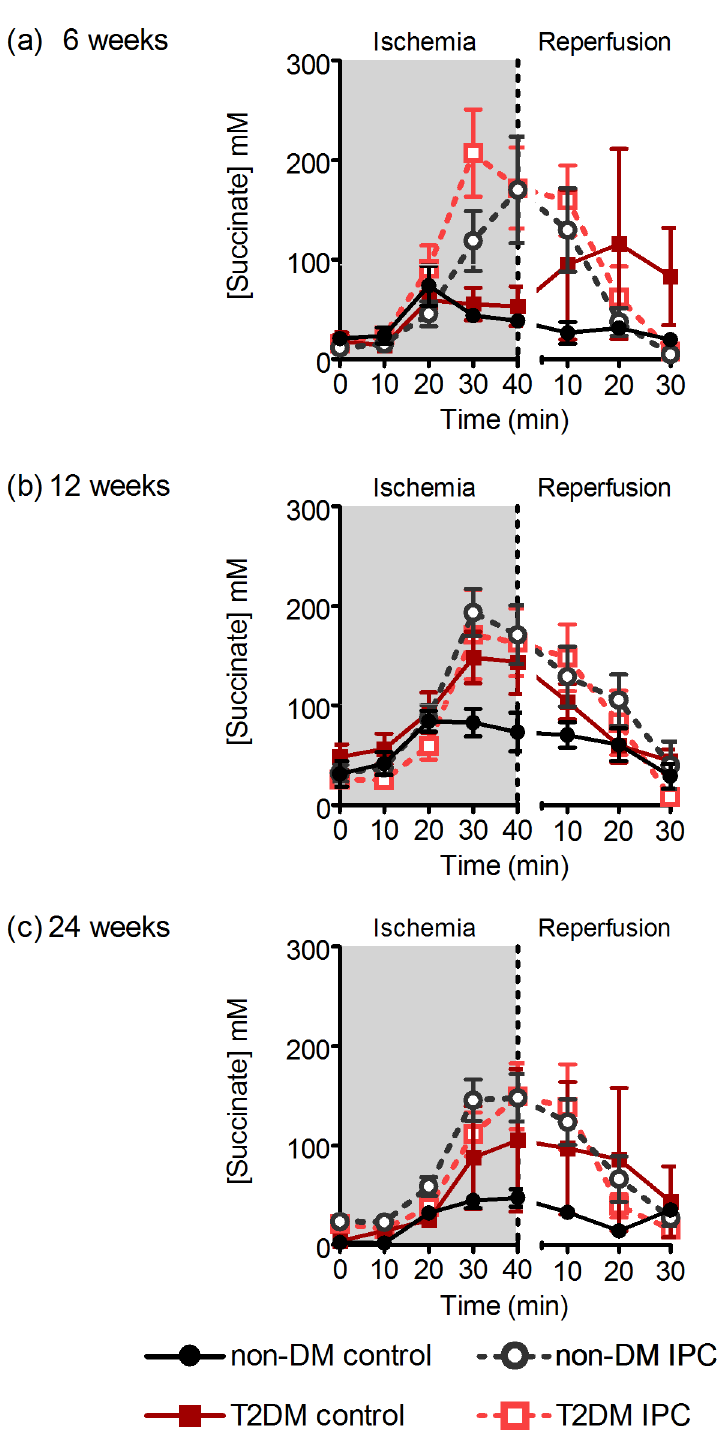
Fig 5. Interstitial succinate concentrations. Interstitial concentrations of succinate during ischemia and reperfusion in 6- (a), 12- (b), and 24-week-old (c) non-DM rats (heterozygote (fa/+)) and DM ZDF rats (homozygote (fa/fa)) after control or IPC-treatment. Data are mean ± SEM (n =